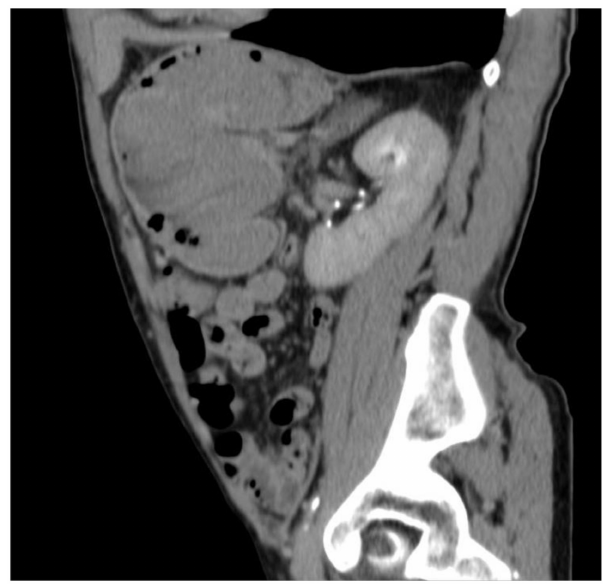
Figure 6. Gastric lesion in the delayed phase in the sagittal